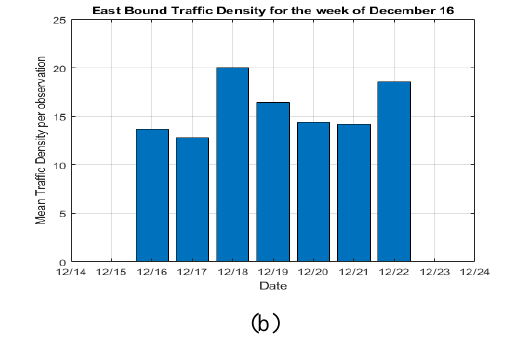
Fig.6. Traffic Density (a) Westbound (b) East